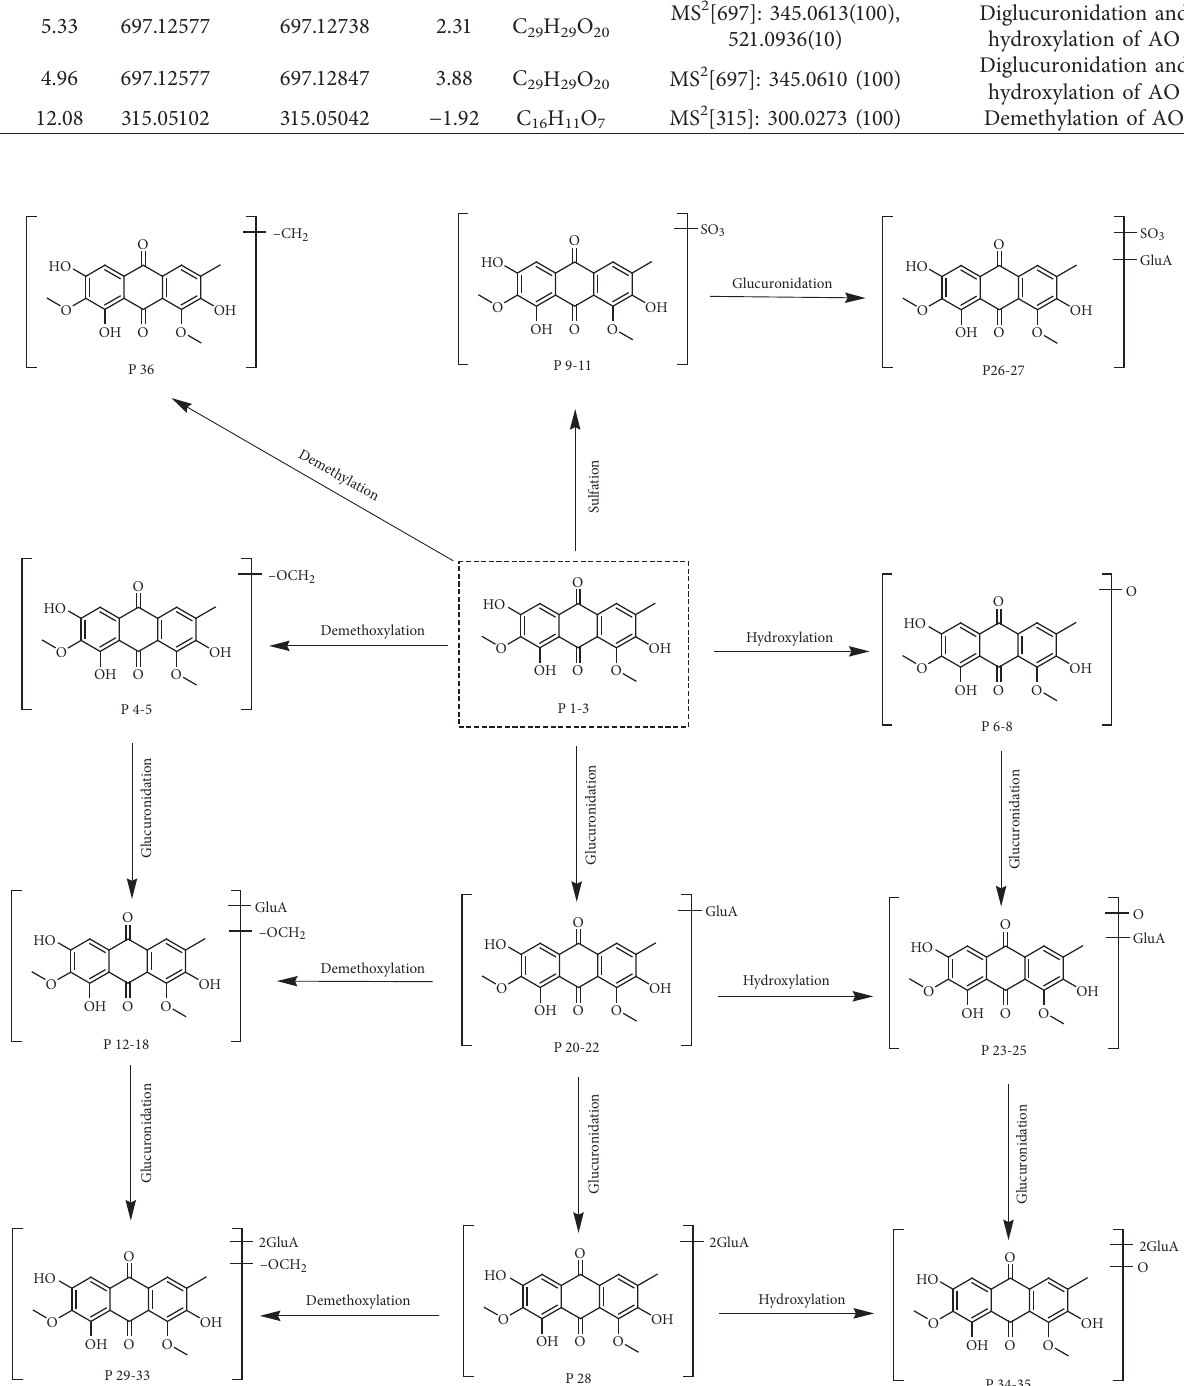
Figure 3: The proposed pathways of AO in the rat